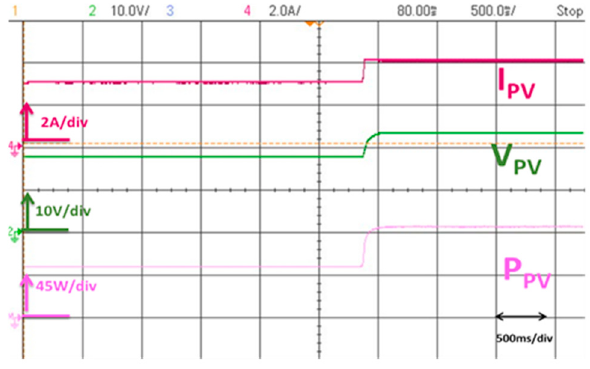
Figure 14. Proposed fixed-frequency predictive MPPT operation waveforms under partial shading condition (step down in the irradiation (Ch2 (green) is PV voltage, Ch4 (pink line) is the PV current), the PV extracted power (lavender line).